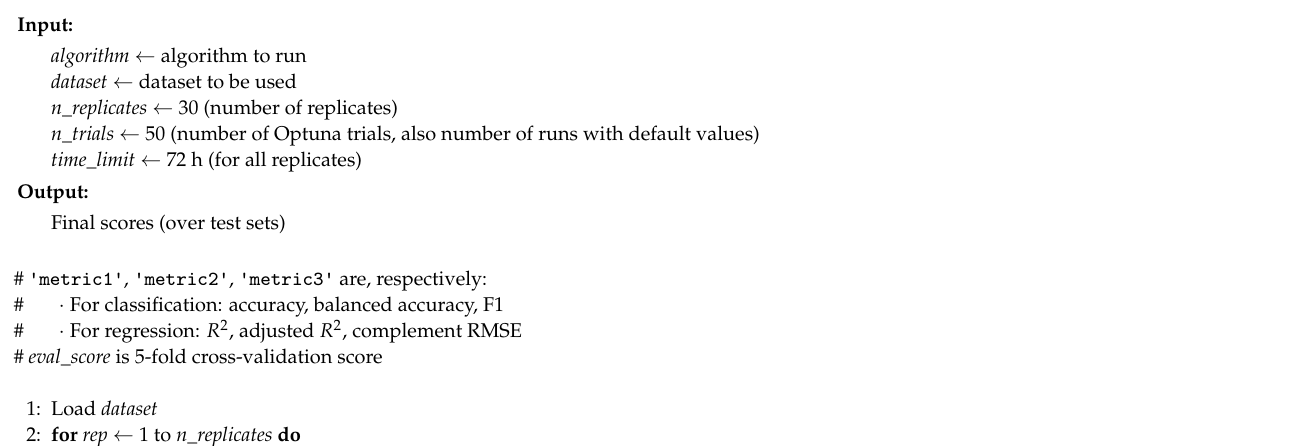
Algorithm 1 Experimental setup (per algorithm and